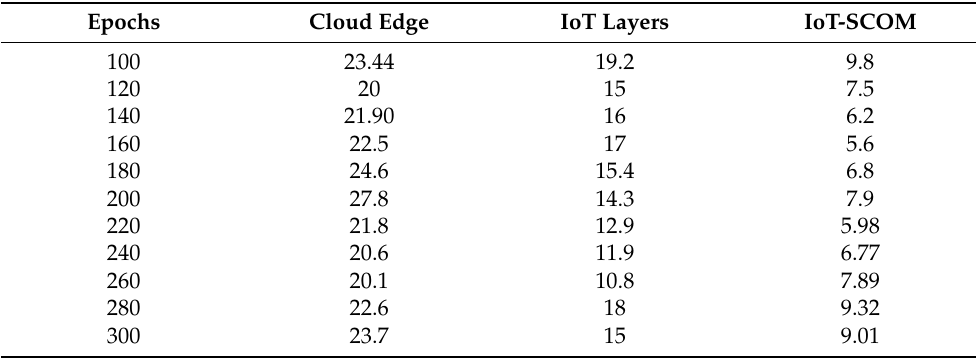
Table 1. The energy consumption (J) of the proposed IoT-SCOM.